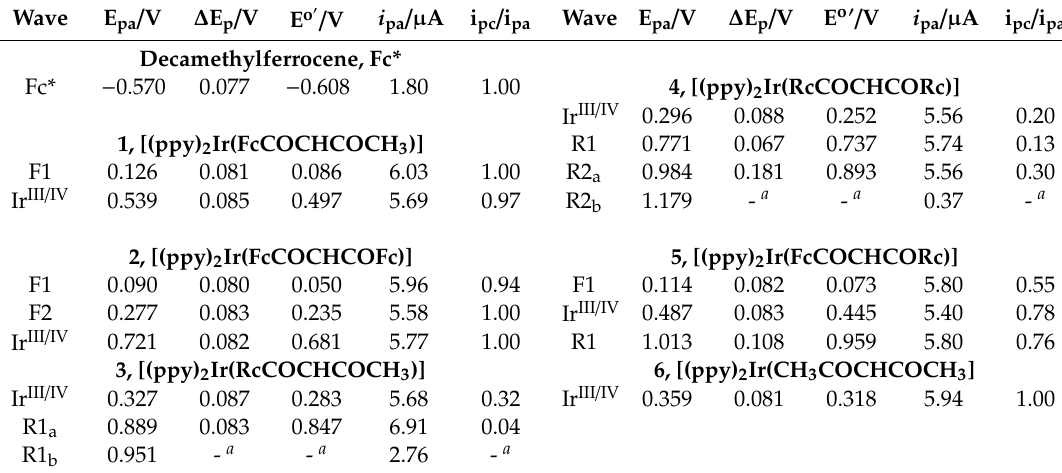
Table 3. Cyclic voltammetry data of 0.5 mmol · dm − 3 solutions of 1–5 in CH 2 Cl 2 containing 0.1 mol · dm −